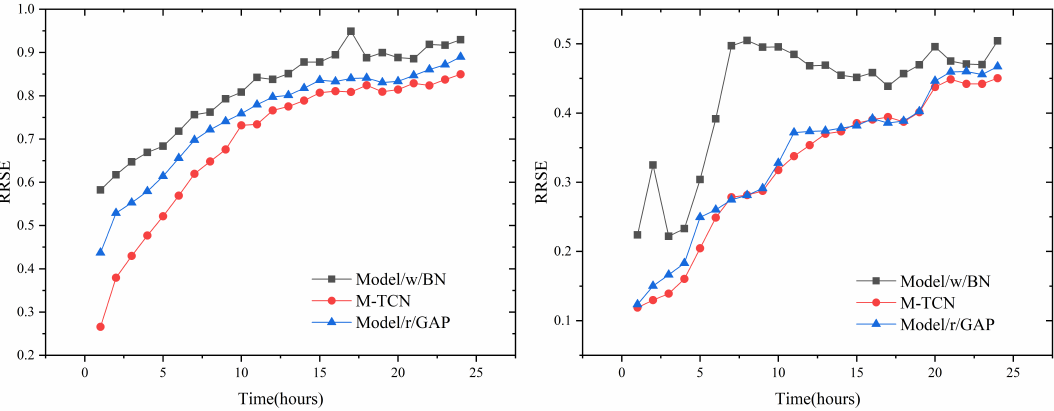
Figure 13. ( left ) RRSE of models over the Beijing PM2.5 dataset. ( right ) RRSE of models over the ISO-NE dataset.